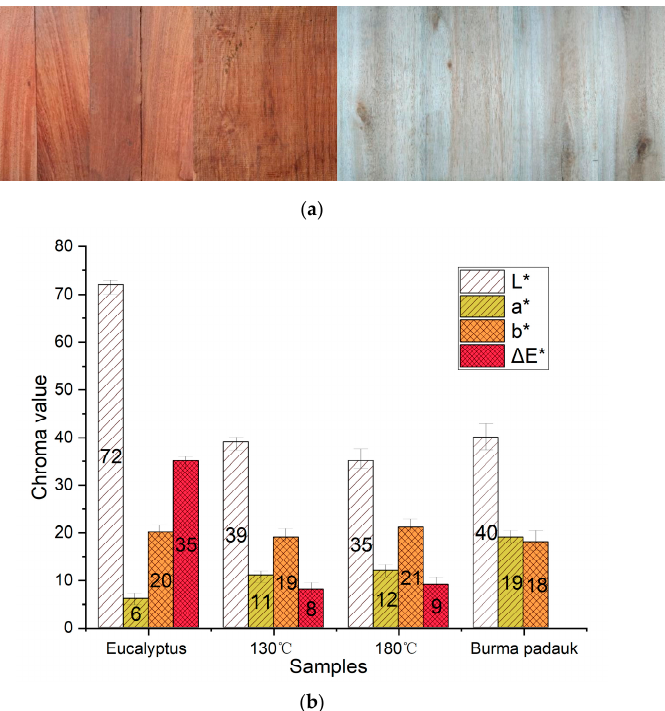
Figure 1. ( a ) Pictures and ( b ) chroma value of Eucalyptus and Burma padauk wood.